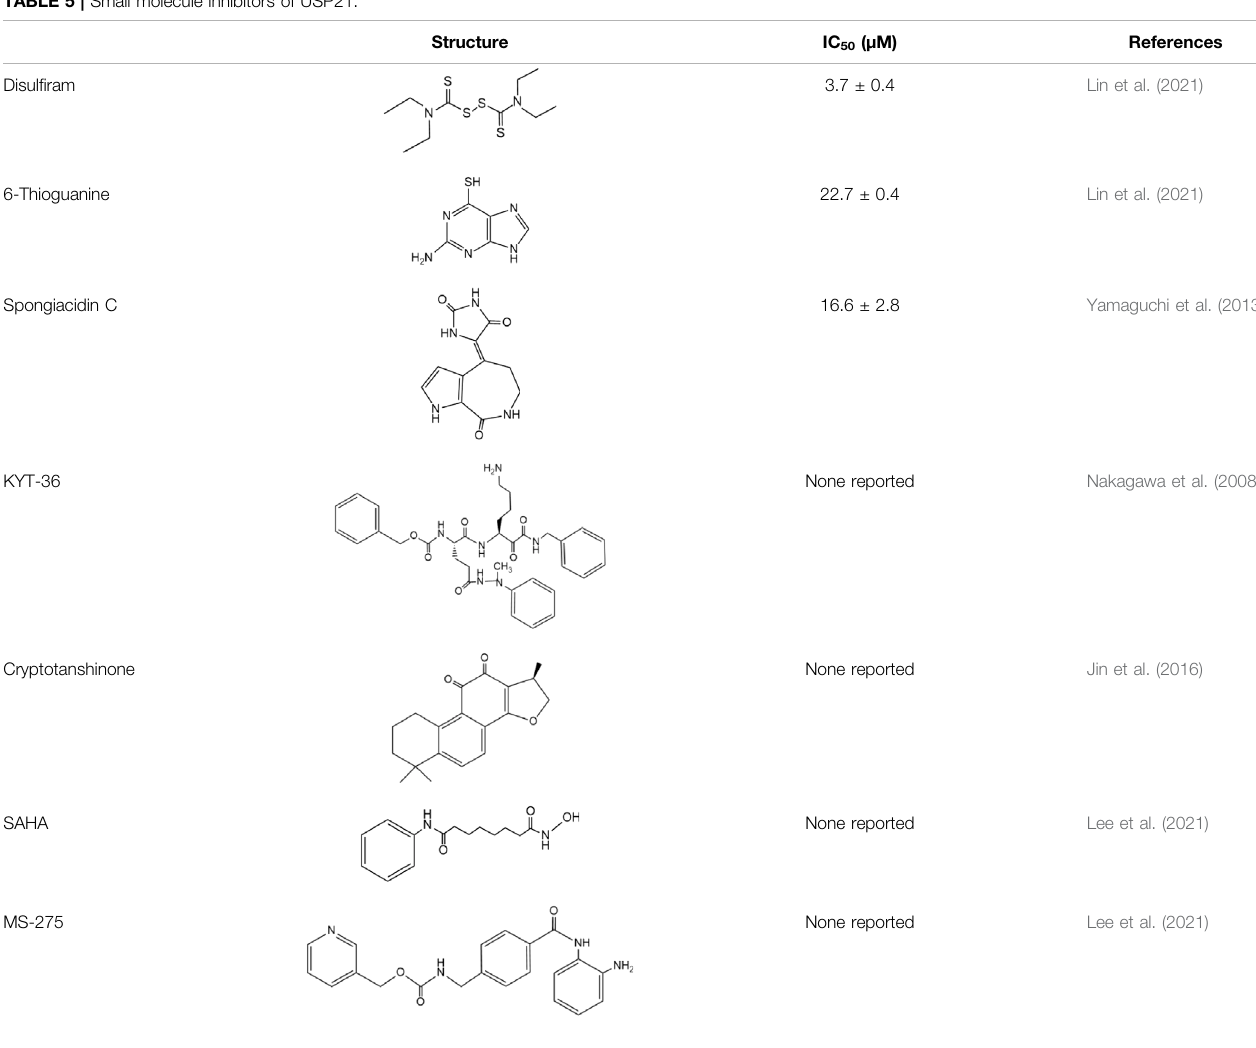
TABLE 5 | Small molecule inhibitors of